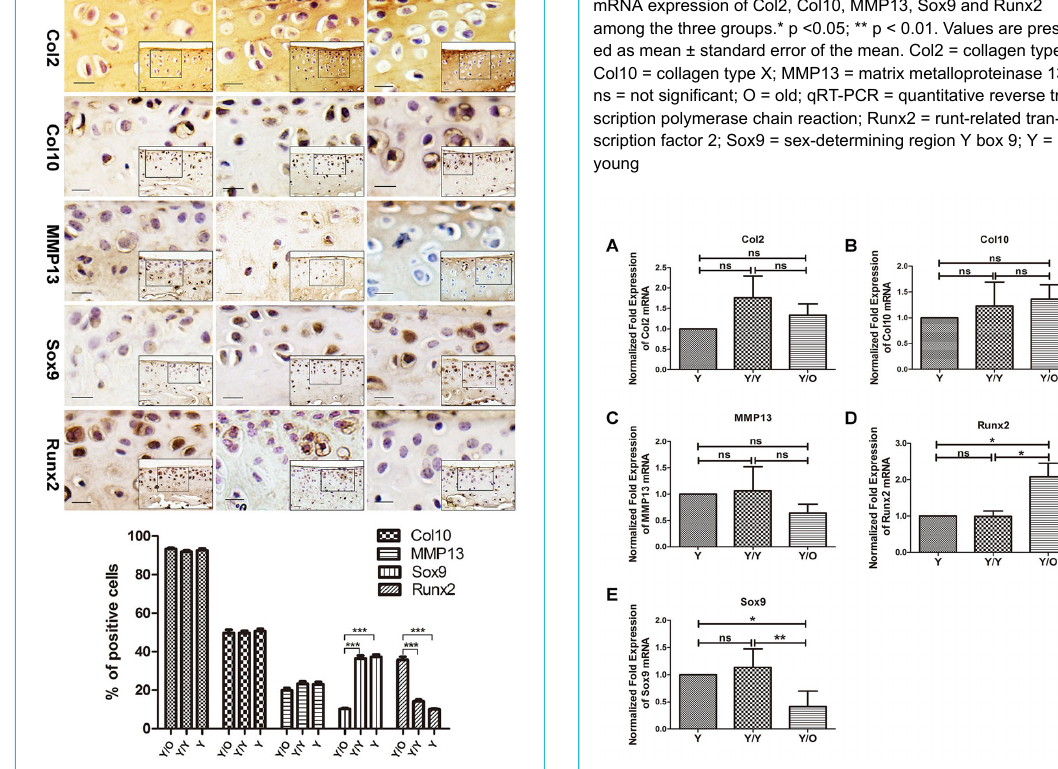
Figure 3: Protein expression of Col2, Col10, MMP13, Sox9 and Runx2 in articular cartilage. Young cartilage samples from Y/O, Y/ Y and Y groups were analysed with immunohistochemistry for Col2, Col10, MMP13, Sox9 and Runx2. Col2, Col10 and MMP13 levels in young cartilage showed no statistically significant differ- ence among the Y/O, Y/Y and Y groups (p >0.05). However, the level of Sox9 was reduced and the level of Runx2 was increased in young cartilage from the Y/O group compared to the Y/Y and Y groups. Scale bar = 200 μm. (8 Y/O mice, 10 Y/Y mice and 10 Y mice were used). One-way ANOVA with Tukey’s post-hoc test was used to assess the difference in the percentage of positive cells with Col2, Col10, MMP13, Sox9 and Runx2 protein expression among the three groups.*** p <0.001. Values are presented as mean ± standard error of the mean. Col2 = collagen type II; Col10 = collagen type X; MMP13 = matrix metalloproteinase 13; O = old; Runx2 = runt-related transcription factor 2; Sox9 = sex-determining